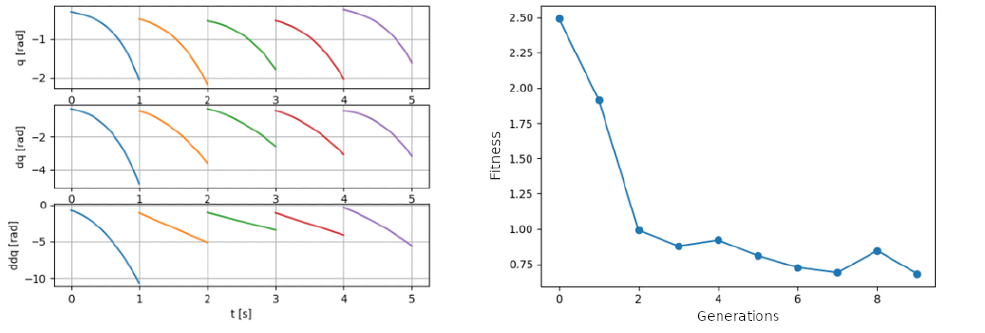
Figure 7. The behavior of the algorithm for the boundary condition set to 0.2. The best-achieved solution is visualized on the ( left ), and the fitness change through generations is on the ( right ). Similar but slightly improved results are achieved with the bound set to 0.1, seen in Figure 8. The range of the movement is kept, but the algorithm converges to a better overall solution. The improved results achieved by setting this value indicate the need to continue testing lower values.